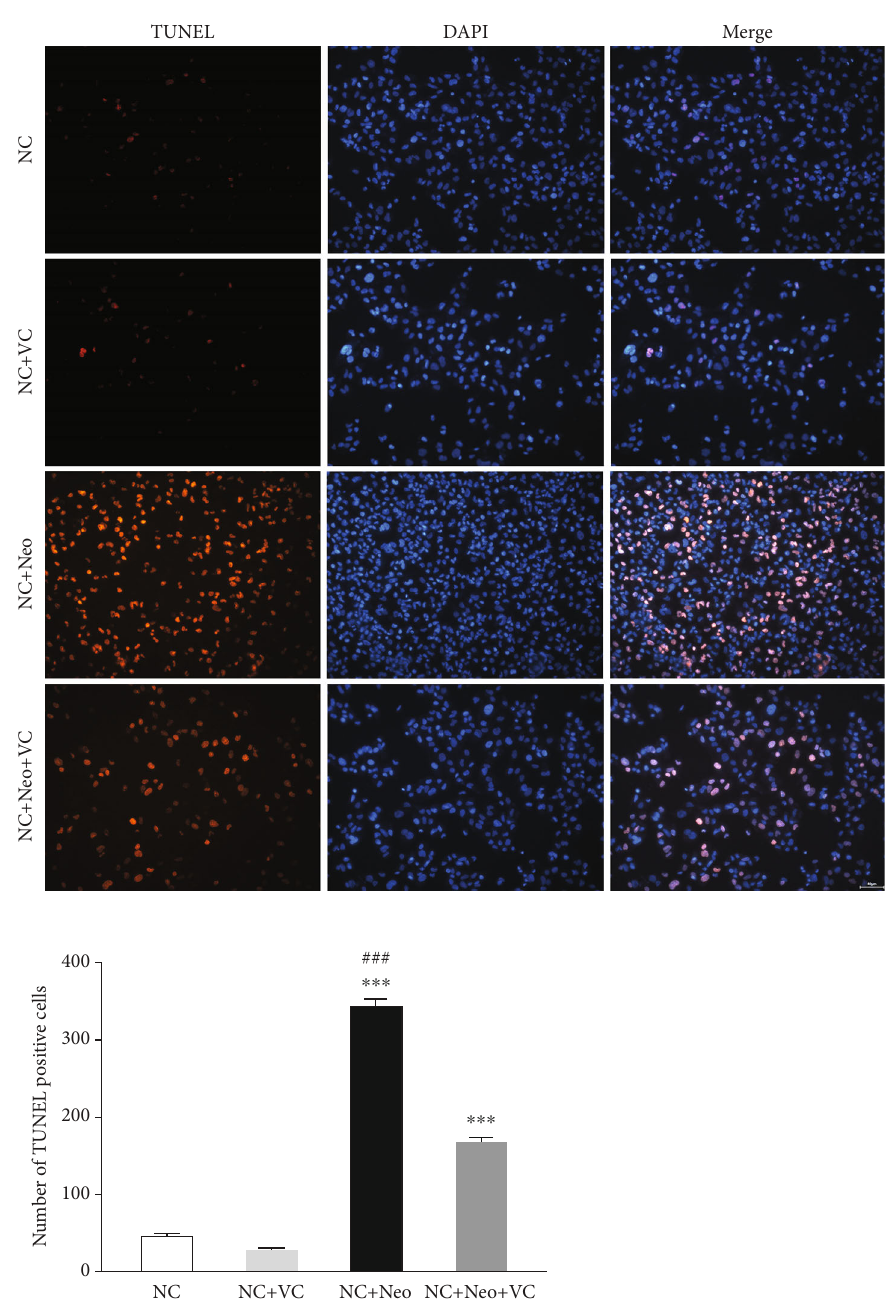
Figure 6: Apoptosis expression in VC and neomycin treated HEI-OC1 cells. The apoptotic cell was detected using TUNEL staining. The TUNEL staining is red and expressed at di ff erent treatment groups, scale bar = 50 μ m. The number of positive TUNEL staining cells with di ff erent treatment. One-way ANOVA, ∗∗∗ p < 0 : 001 versus NC group and ### p < 0 : 001 versus NC+Neo+VC group. All tests were repeated three times